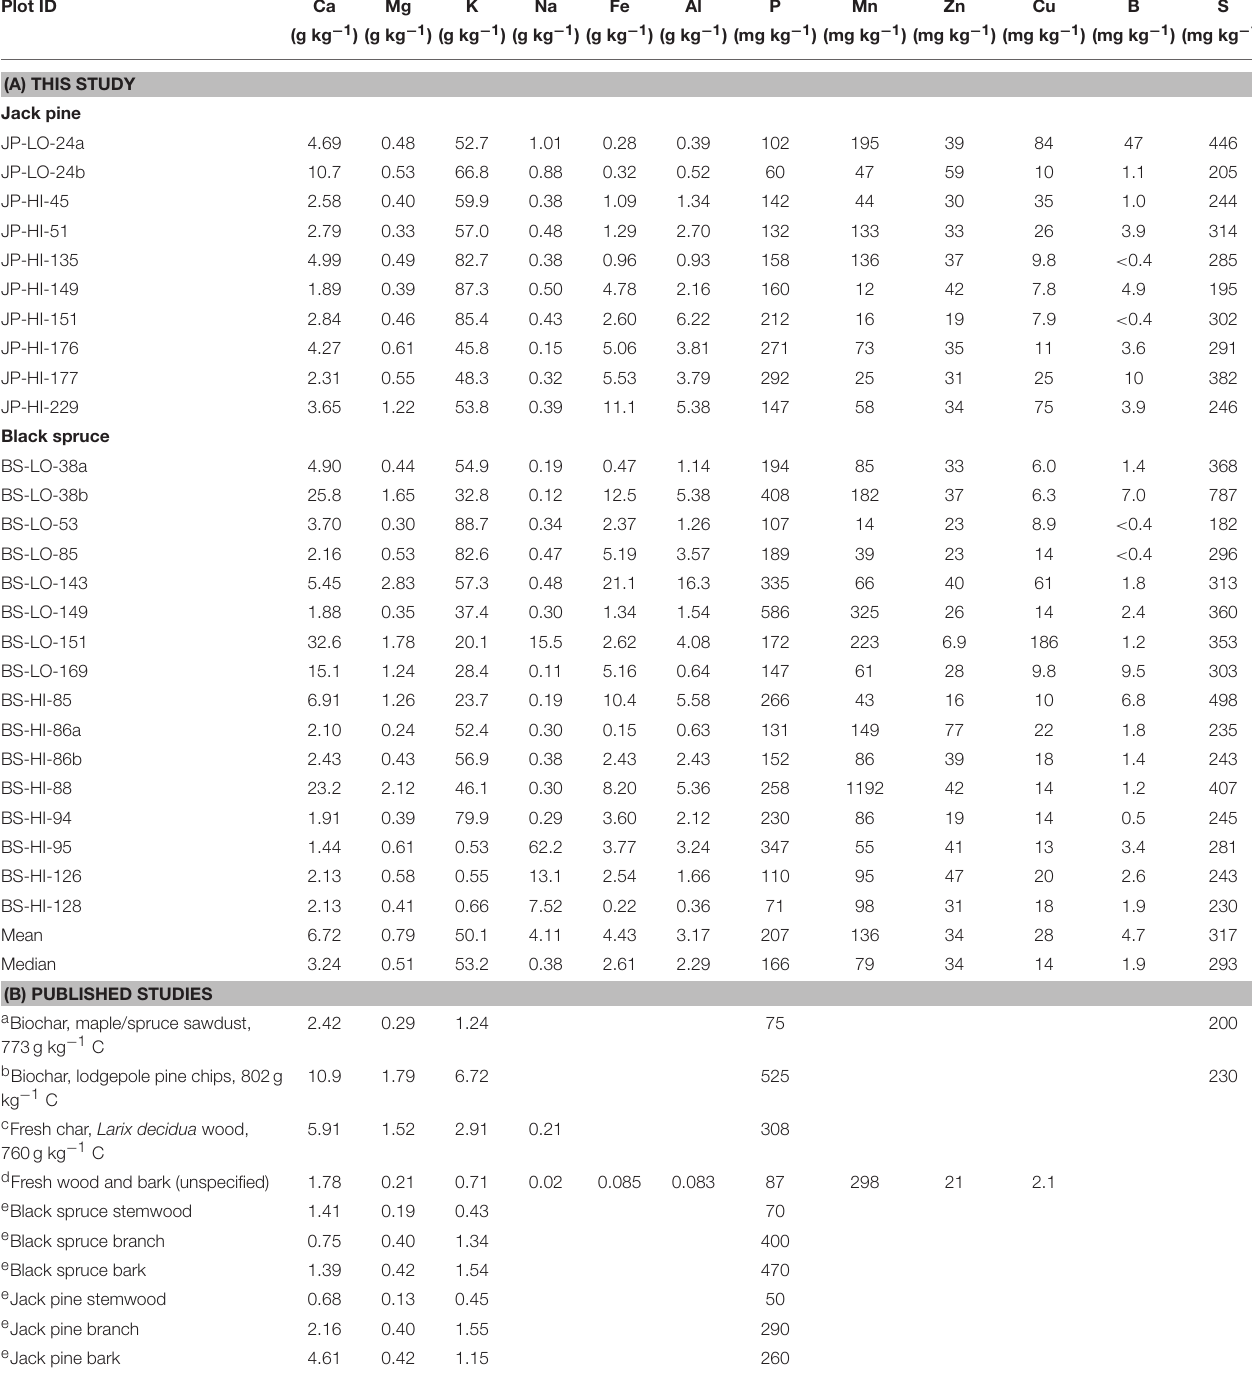
TABLE 3 | Elemental composition of charcoal samples > 2 mm determined by ICP (A) for this study and (B) in the literature. Plot ID Ca Mg K Na Fe Al P